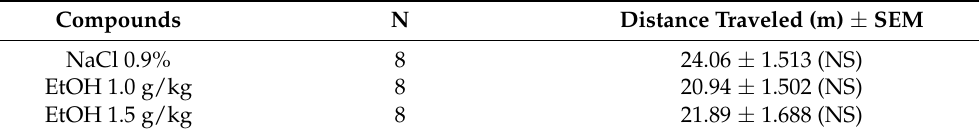
Table 2. Effect of early ethanol exposure on ethanol-induced locomotor activity in the CPP test.